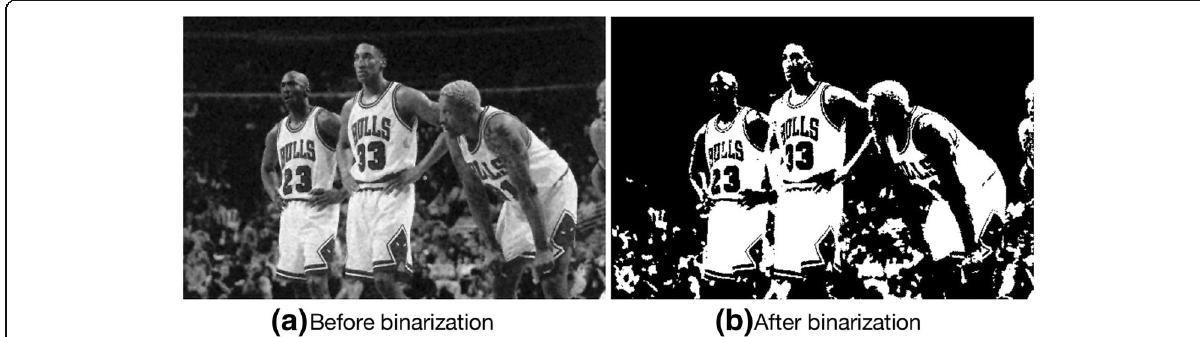
Fig. 5 Image binarization processing. a Before binarization. b After binarization